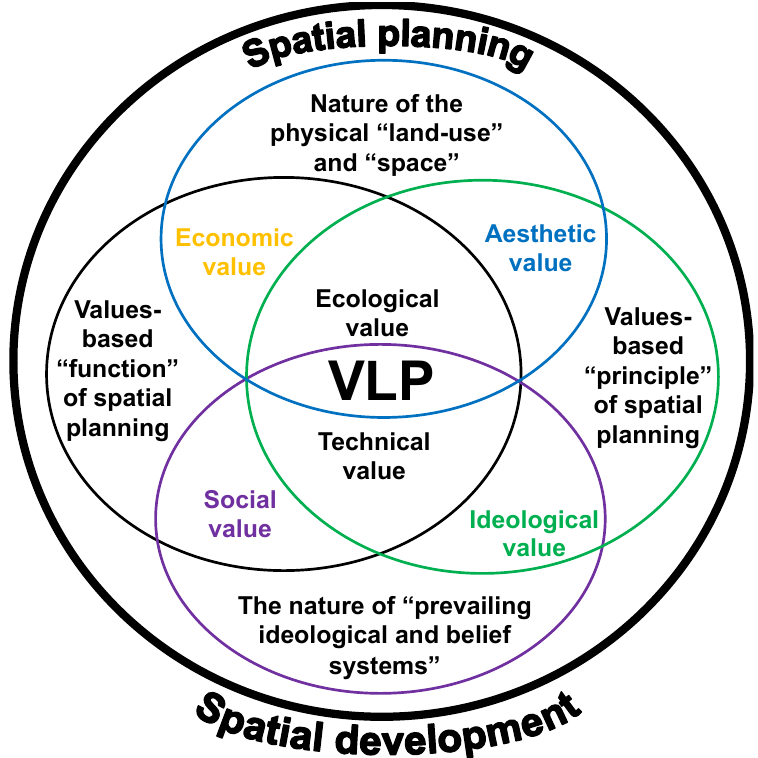
Figure 2. VLP is a consequence of an interaction between four key elements of spatial planning.